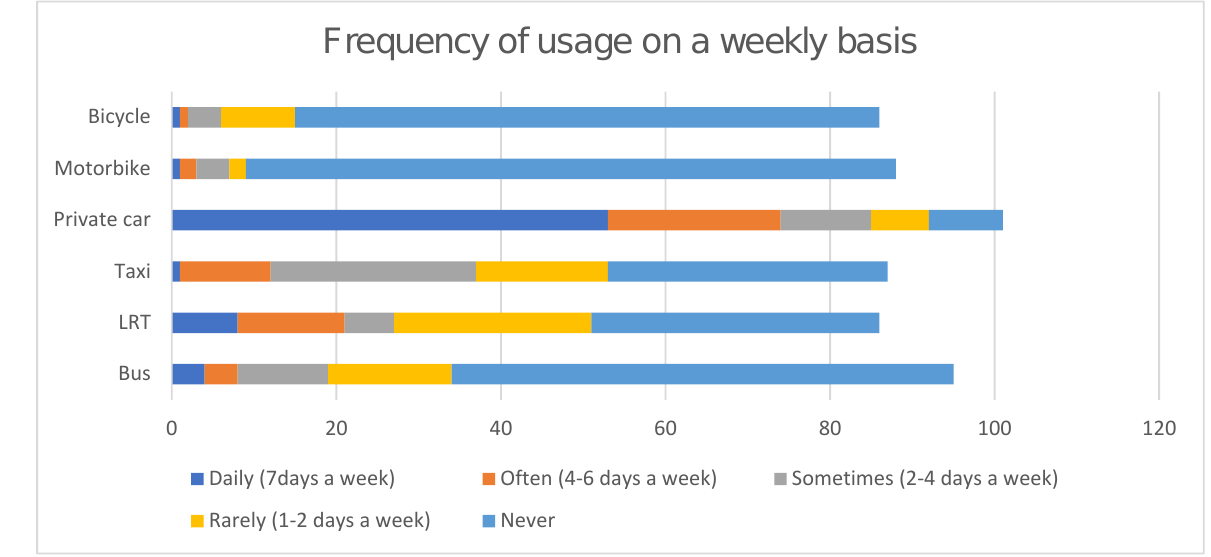
Figure 5. The frequency of different transport mode usage in KL, Malaysia.